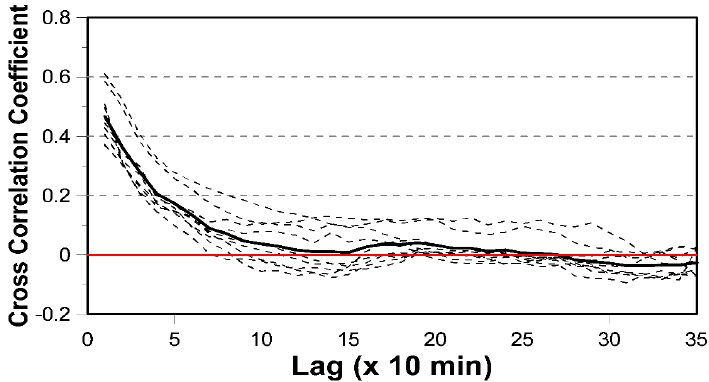
Figure 3. Change of the cross-correlation coefficient with respect to the time lag derived with the forecasts collected at the 10 target times and their average.